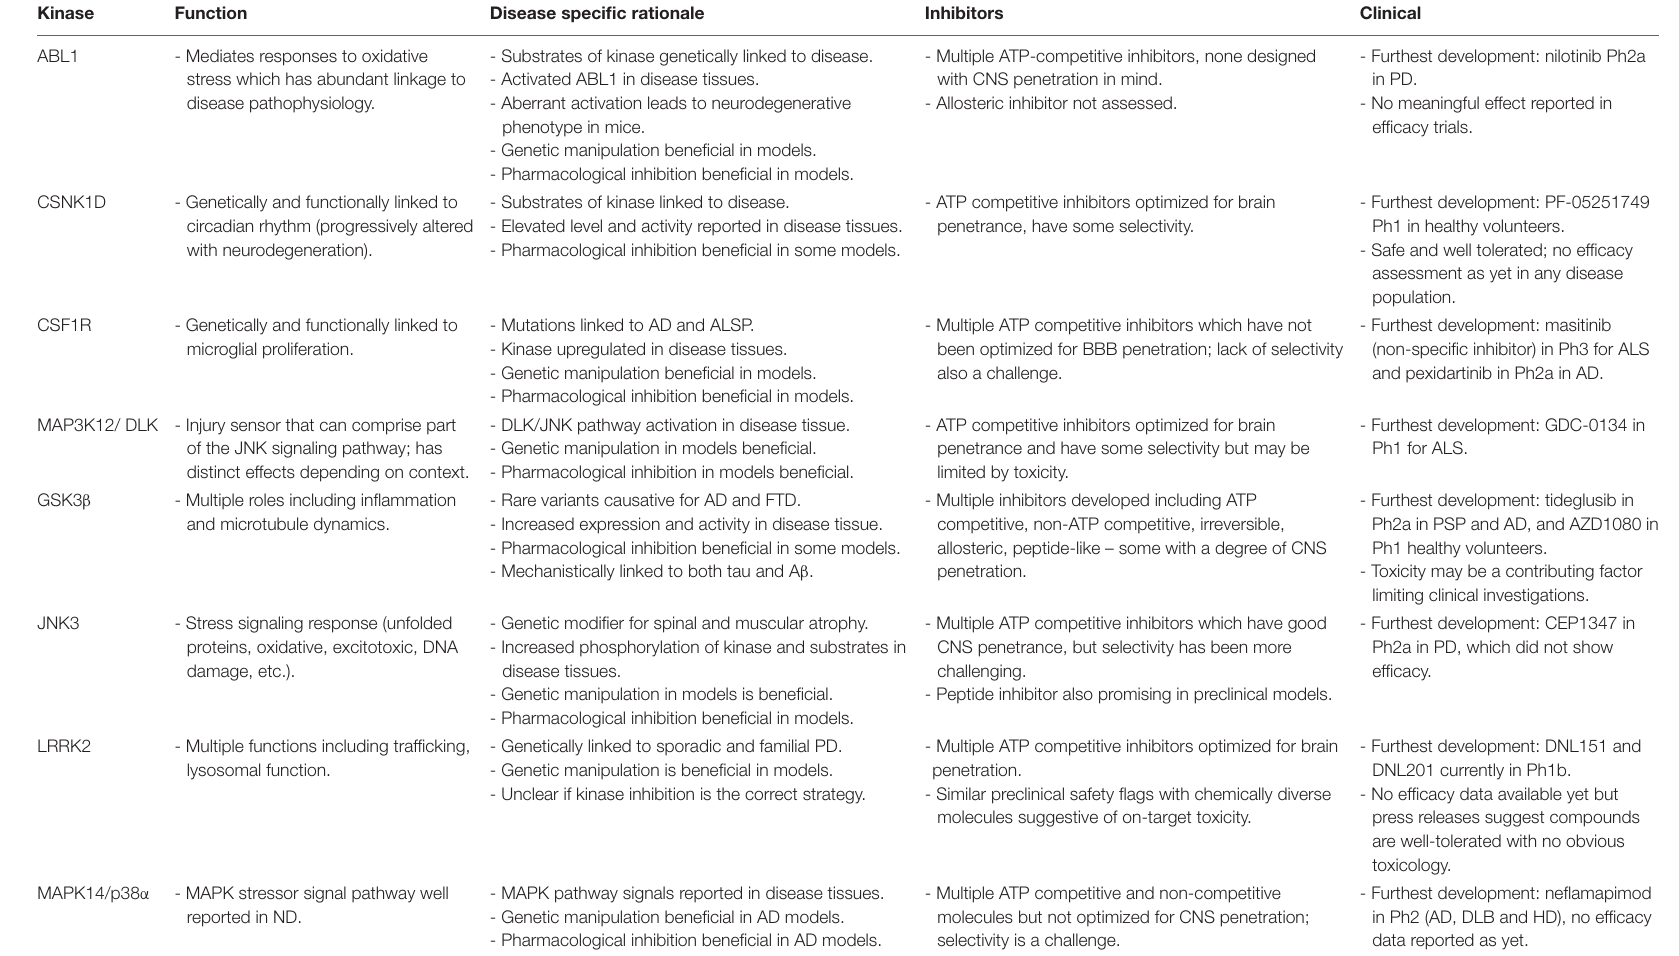
TABLE 1 | Summary of kinases covered in manuscript with respect to function, disease association, inhibitors, and clinical development. Kinase Function Disease specific rationale Inhibitors